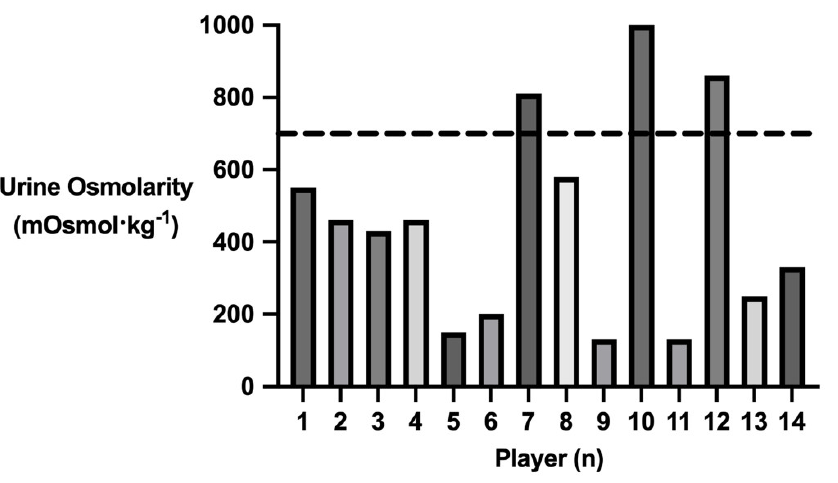
Figure 1. Player’s pre-session urine osmolarity. Dotted line denotes 700 mOsmol · kg − 1 .